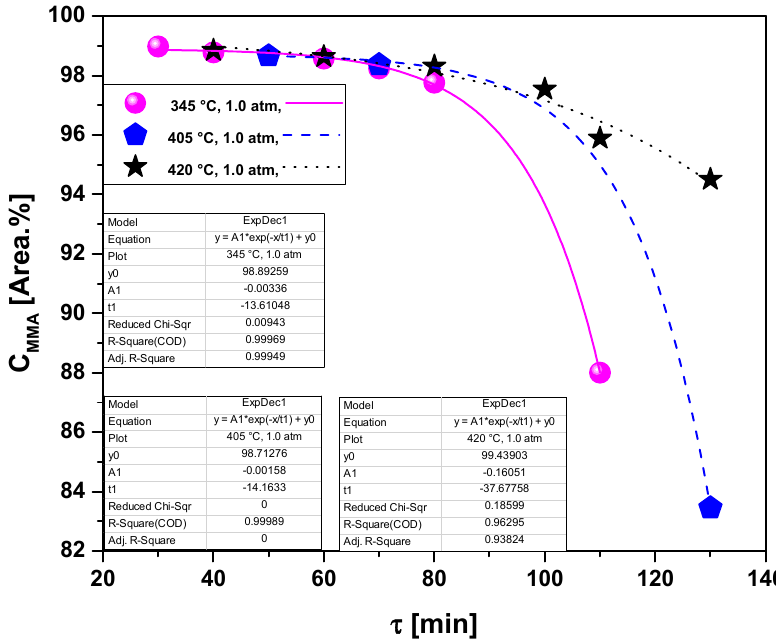
Figure 9. Concentration of MMA in liquid phase by depolymerization of PMMA based dental resins fragments/residues at 345 °C, 30, 40, 50, 60, 70, 80, and 110 min, 405 °C, 50, 70, and 130 min, and at 420 °C, 40, 50, 80, 100, 110, and 130 min, and atmospheric pressure, in pilot scale. Table 6. Functional groups, sum of peak areas, chemistry registry numbers (CAS), and retention times of molecules identified by gas chromatography-mass spectrometry (GC-MS) in the liquid phase by depolymerization of PMMA based dental resins fragments/residues at 345 °C, atmospheric pressure, and time interval of 30 to 110 min.